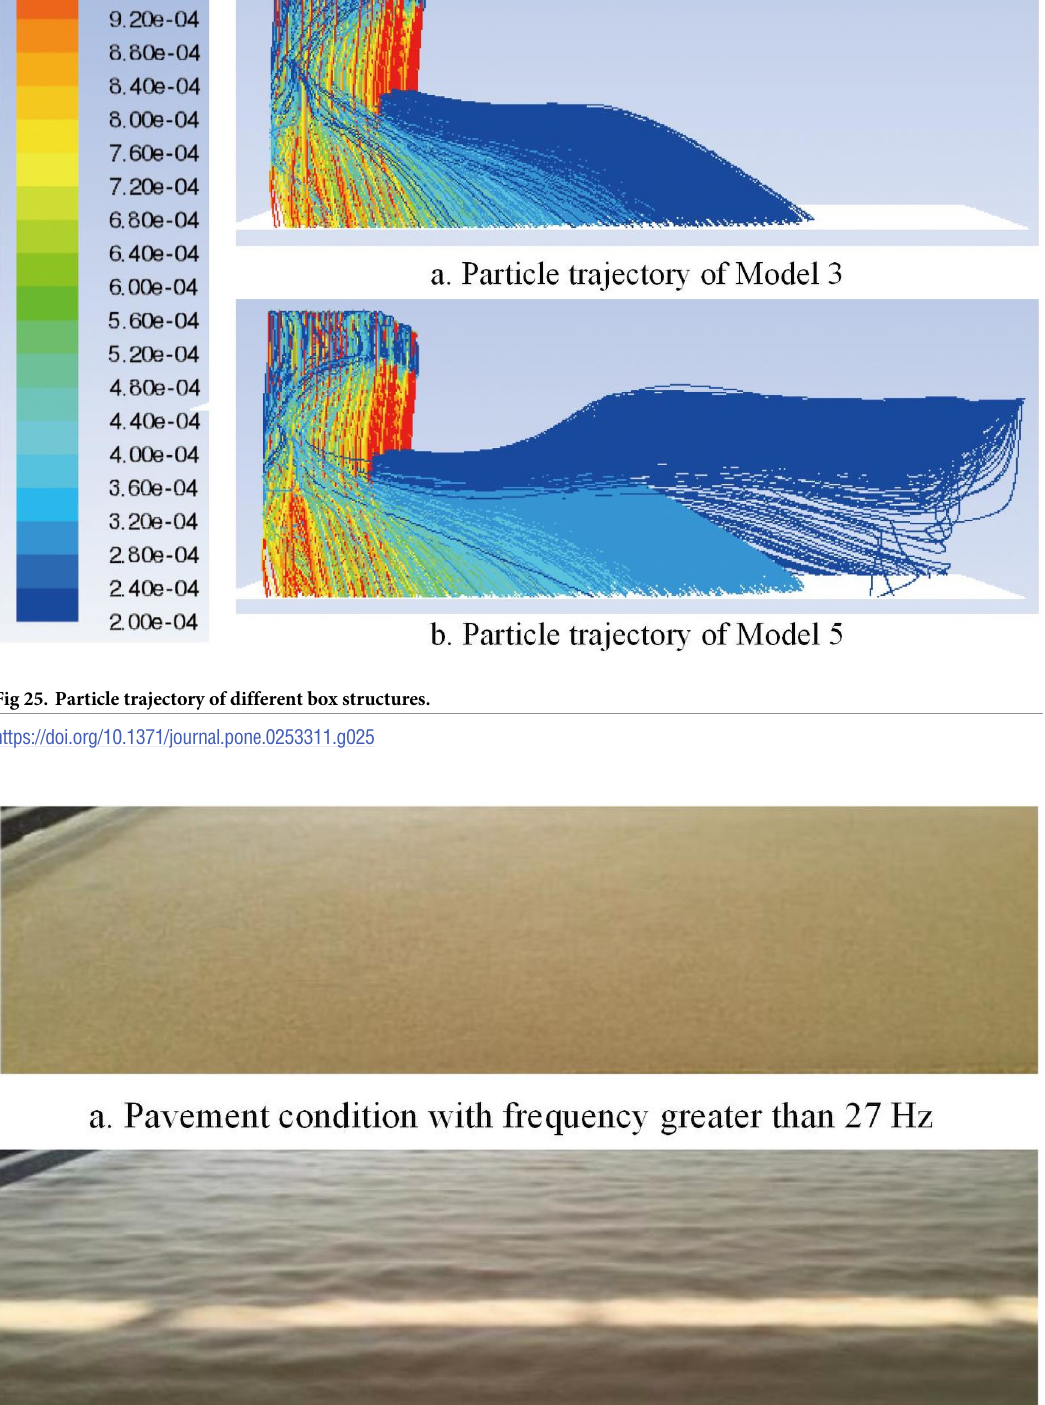
PLOS ONE | https://doi.org/10.1371/journal.pone.0253311 June 17,